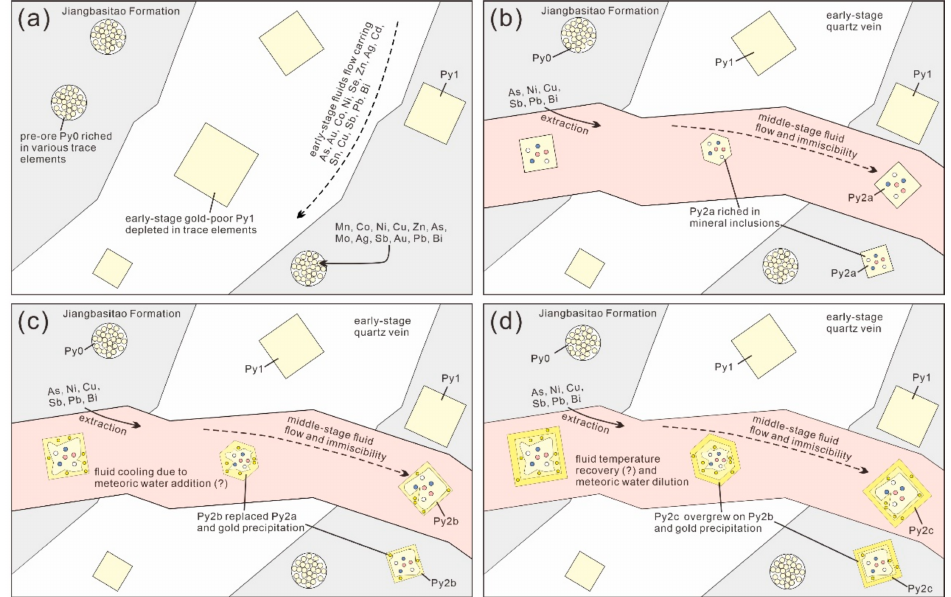
Figure 14. Schematic diagrams showing the formation processes for the different types of pyrites from the Dunbasitao deposit. ( a ) The pre-ore Py0 hosted various trace elements during the sedimentary process of the Jiangbasitao Formation. Initial metamorphic fluids carried major amounts of As, Au, Co, Ni, Se, Zn, Ag, Cd, Sn, Cu, Sb, Pb, Bi, and other elements. In the early stage, coarse-grained, cubic, homogeneous, barren Py1 precipitated from fluids, which was poor in various trace elements. ( b ) In the middle stage, the fluid immiscibility led to the dramatic precipitation of most trace elements, forming the fine-grained, cubic, and/or pyritohedron Py2a rich in trace elements. ( c ) Subsequently, a significant drop in the fluid temperature led to the dissociation of the Au complex. The ore-forming fluids replaced the Py2a and formed the gold-rich Py2b. ( d ) After that, the temperature of ore-forming fluids recovered slightly, the meteoric water kept diluting the fluid, and fluid f O 2 increased, which was companied by the Py2c overgrew on Py2b and the decrease in the most element